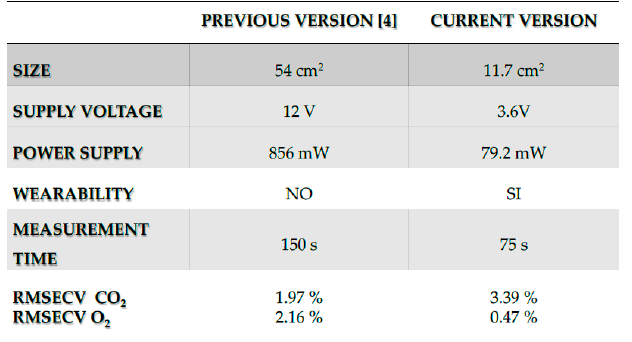
Table 1. Comparison between the previous [4] and the current version of the gas sensors in terms of size, supply voltage, power supply, wearability, measurement time and RMSECV with respect to CO 2 and O 2